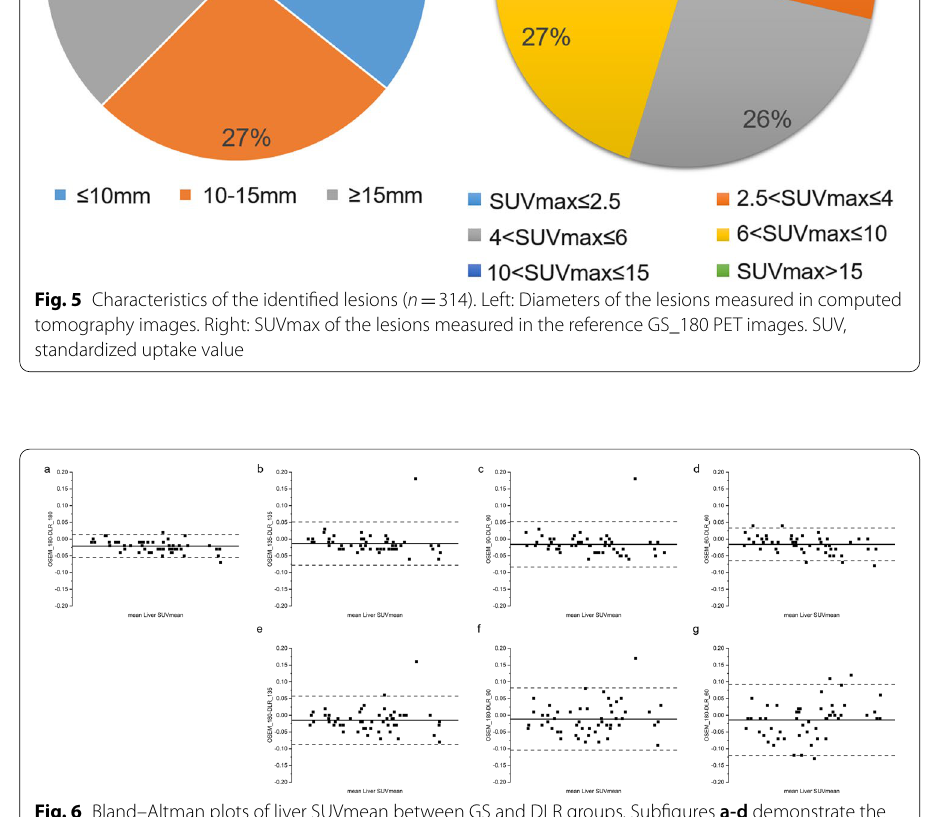
Fig. 6 Bland–Altman plots of liver SUVmean between GS and DLR groups. Subfigures a-d demonstrate the agreement of liver SUVmean between GS and DLR images with the same acquisition durations. Subfigures a , e , f and g demonstrate the agreement of liver SUVmean between DLR groups and the reference GS_180 group. The above plots show minimal differences in liver SUV between groups. SUV, standardized uptake